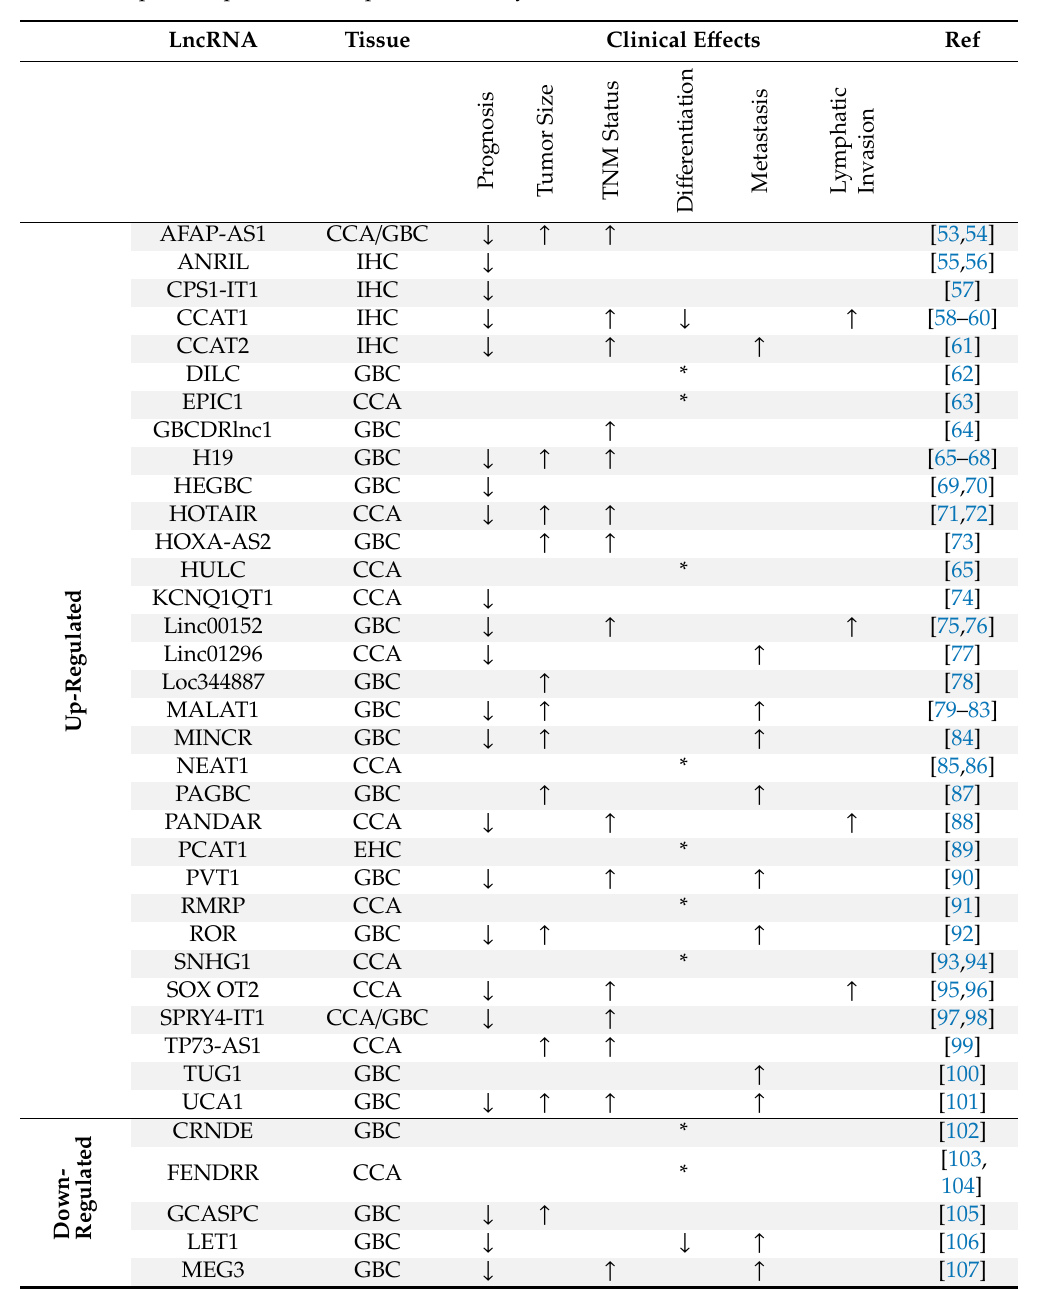
Table 1. Overview of up-regulated (‘oncogenic‘) and down-regulated (‘suppressive‘) lncRNAs in biliary tract cancer patient specimens compared to healthy tissue and the associated clinical e ff